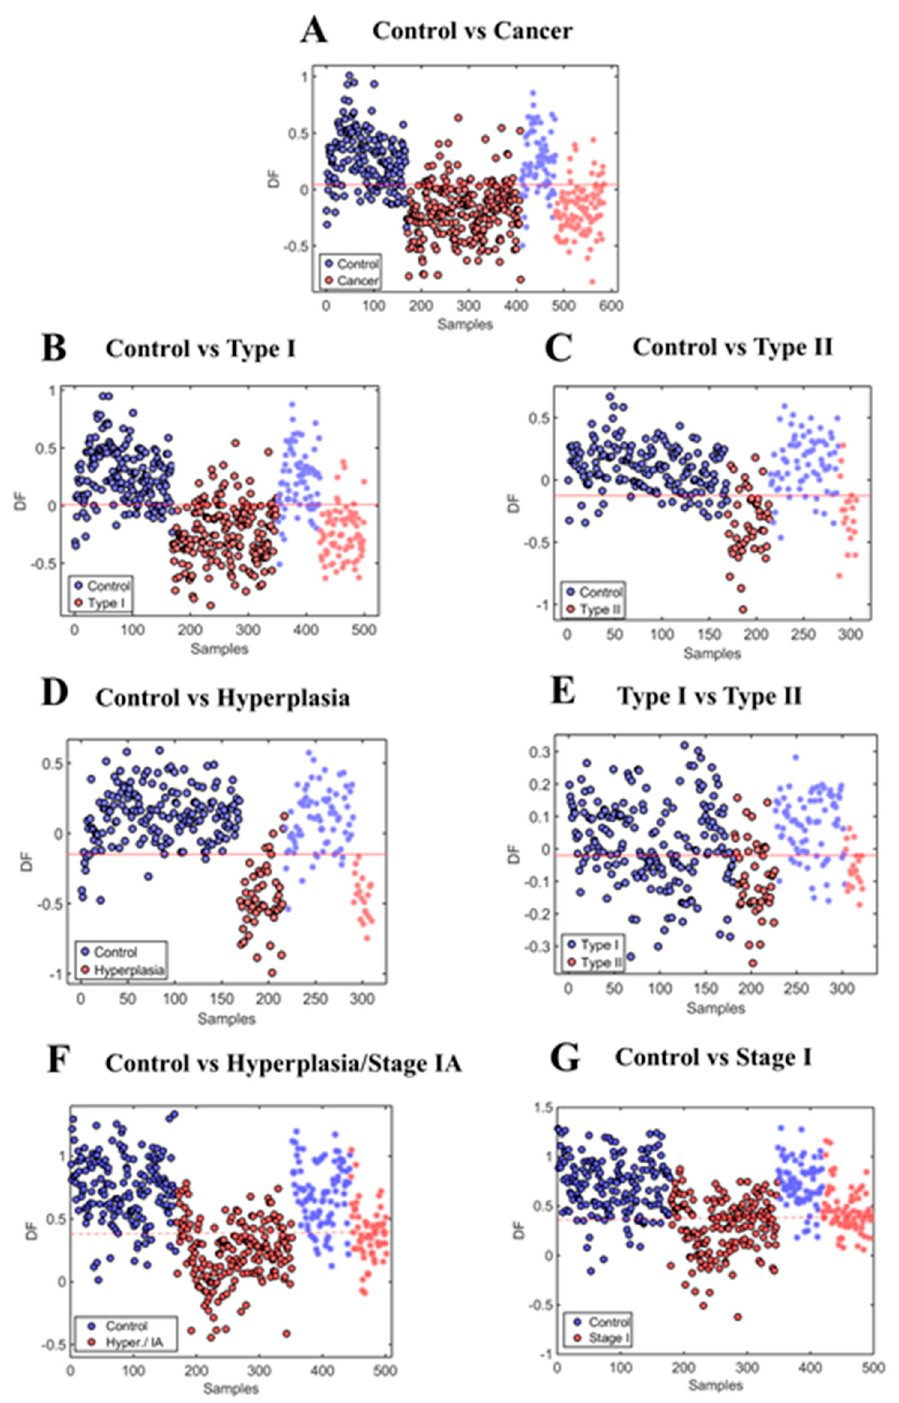
Figure 2. Discriminant function (DF) graphs showing the di ff erences and similarities between the di ff erent classes after supervised partial least squared discriminant analysis (PLS-DA). ( A ) Control ( n = 242) vs. cancer ( n = 342; including Type I ( n = 258), Type II ( n = 64) and mixed ( n = 20)). ( B ) Control ( n = 242) vs. Type I cancers ( n = 258). ( C ) Control ( n = 242) vs. Type II ( n = 64) cancers. ( D ) Control ( n = 242) vs. hyperplasia ( n = 68). ( E ) Type I ( n = 258) vs. Type II cancers ( n = 64). ( F ) Control ( n = 242) vs. hyperplasia / Stage IA ( n = 260). ( G ) Control ( n = 242) vs. Stage I ( n = 254). o: training samples; *: test samples.